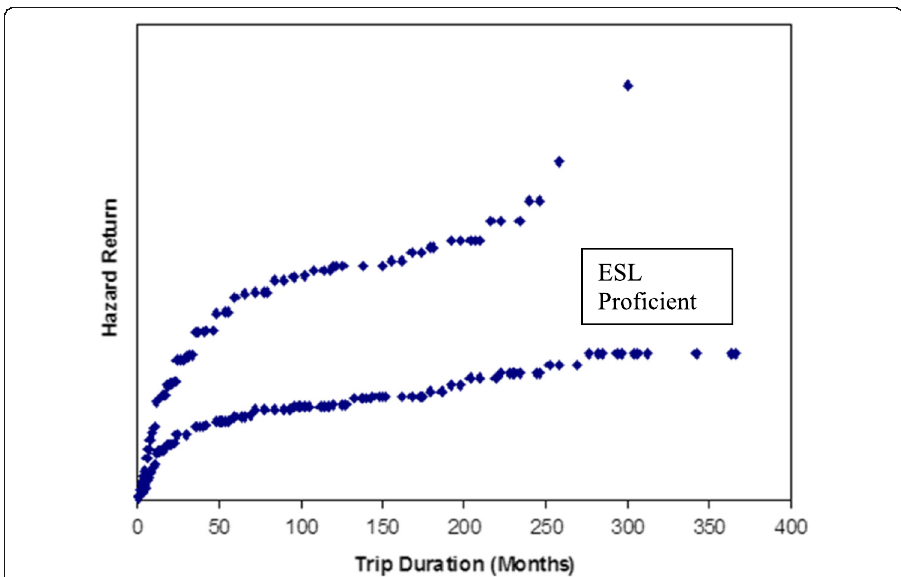
Fig. 4 Estimated baseline hazard for last migration sample by English